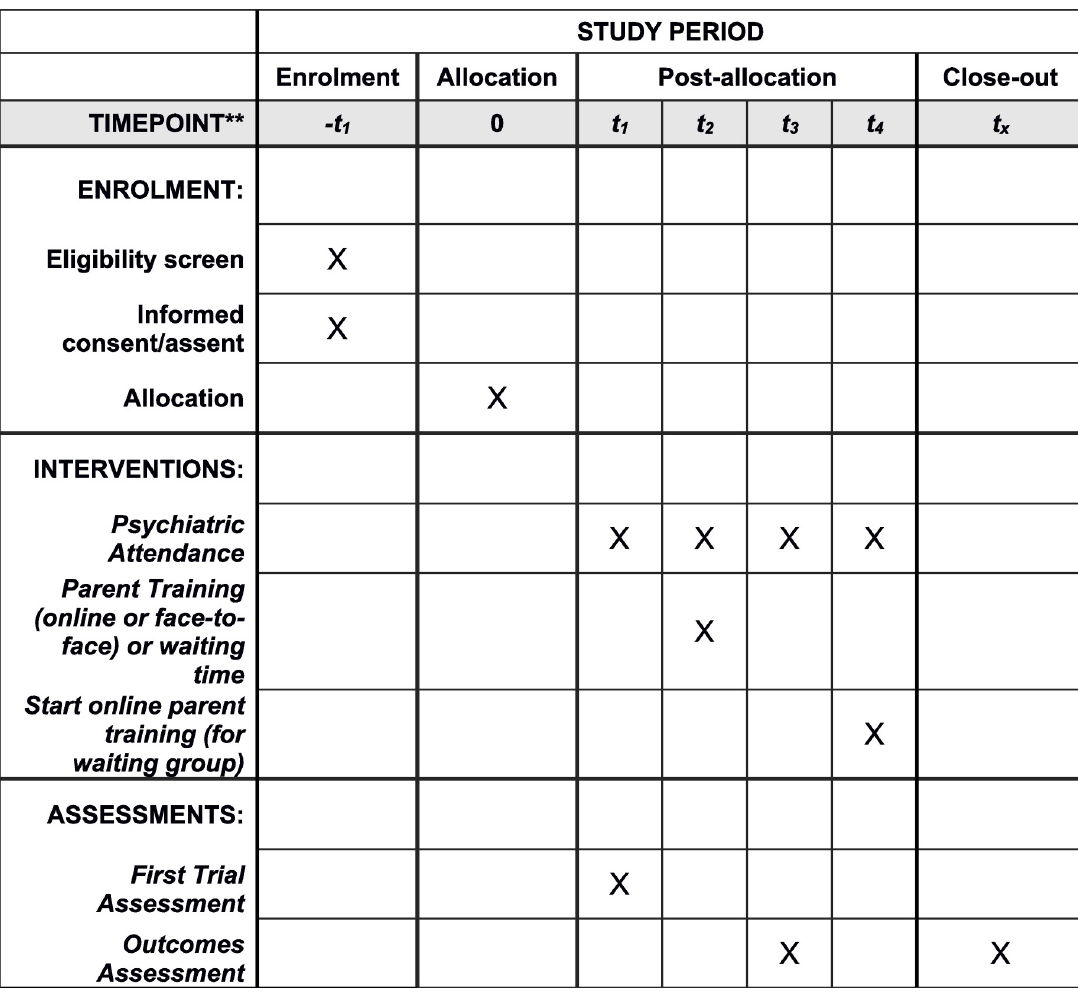
Fig 3. Schedule of enrolment, interventions, and